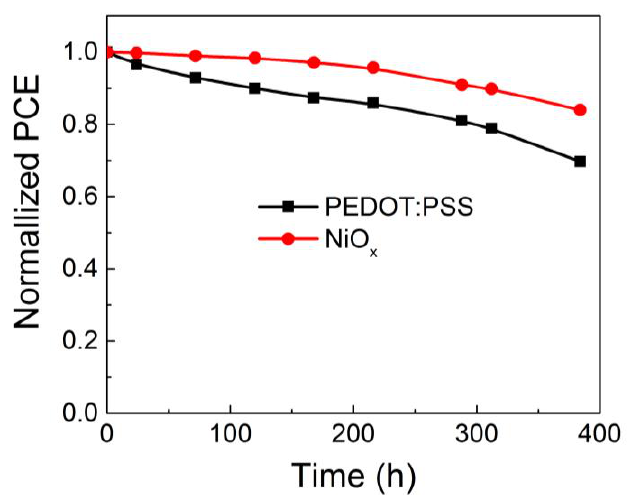
Figure 6. Long-term stability of the PCE for unencapsulated OSCs based on either PEDOT:PSS or NiO x anode buffer layers. The devices have been stored in N 2 filled glove box.